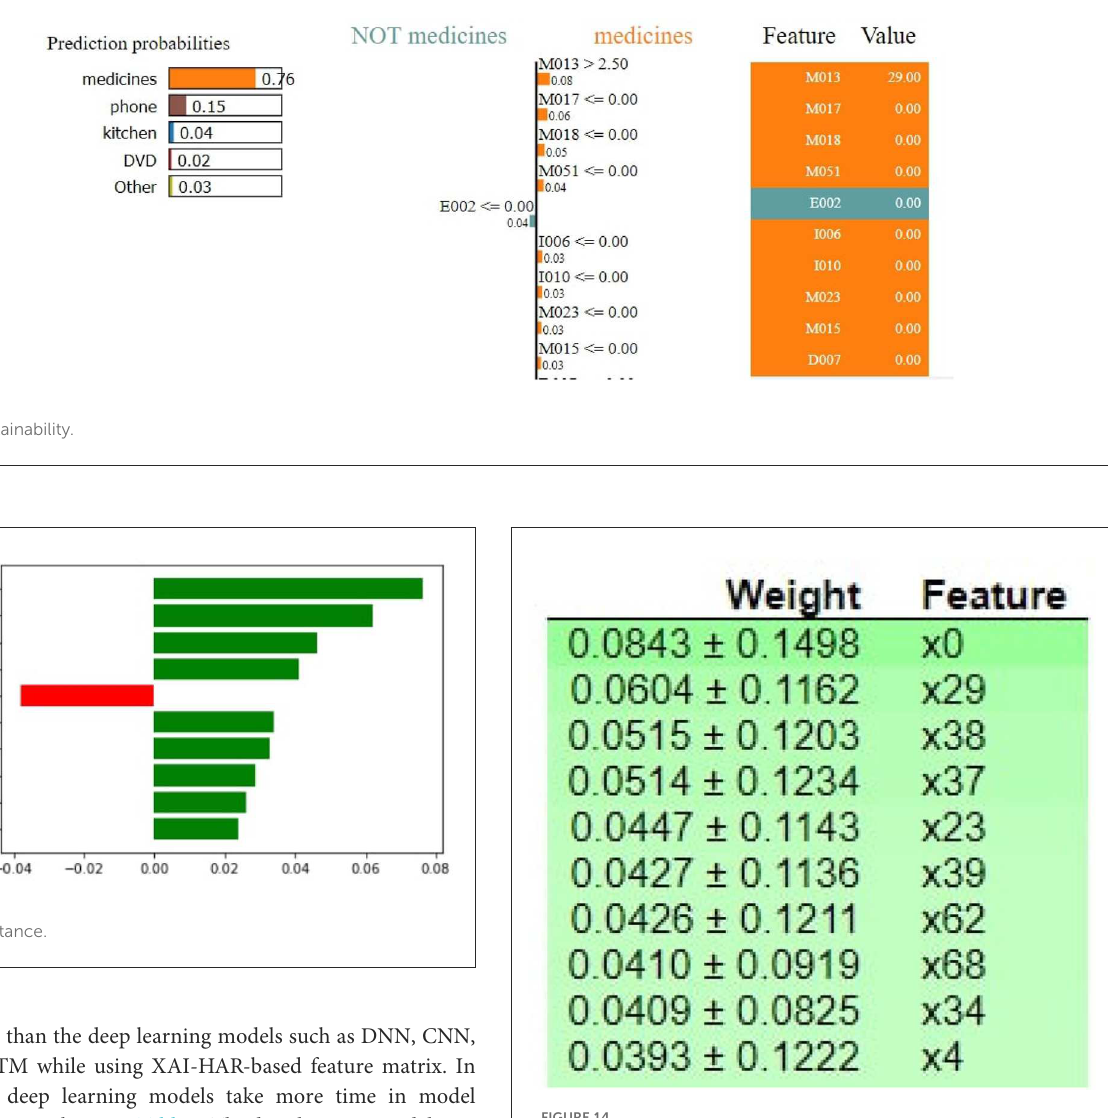
FIGURE14 ELI5-based feature